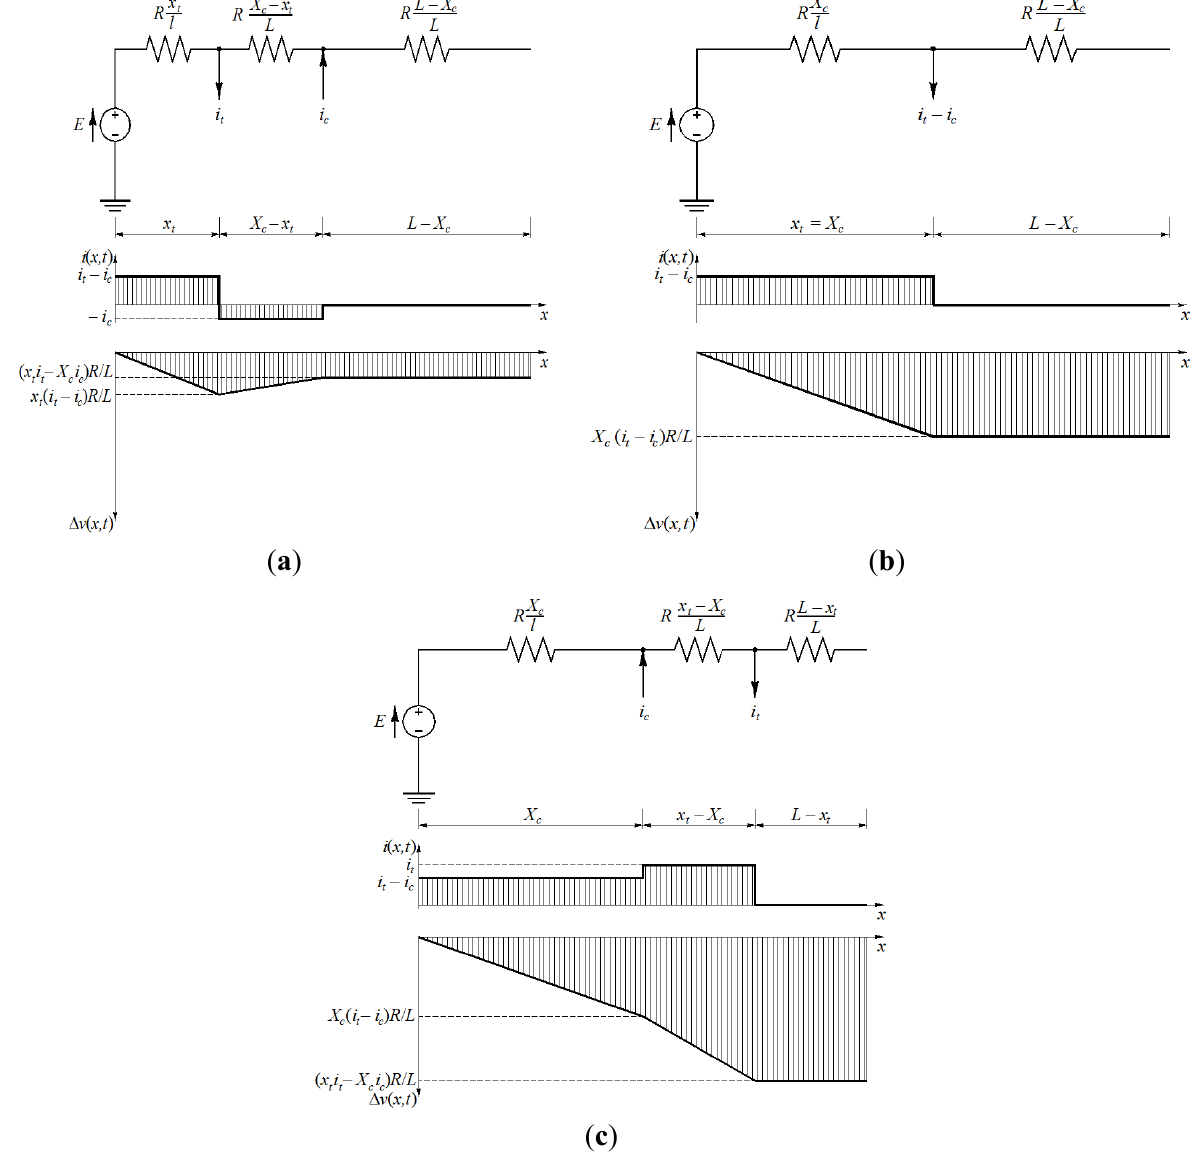
Figure 4. ( a ) Current and voltage drop along the line for different positions of the train; ( b ) Current and voltage drop along the line for different positions of the train; ( c ) Current and voltage drop along the line for different positions of the